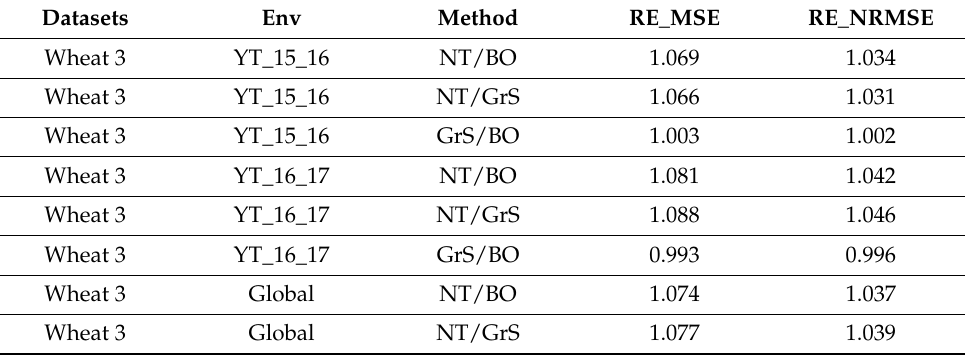
Table A6. Prediction performance for each environment and across environments (Global) of dataset 3 in terms of their relative efficiencies (RE) under two metrics (MSE and NRMSE). In the column method we represent the two tuning strategies that were used to compute RE_MSE and